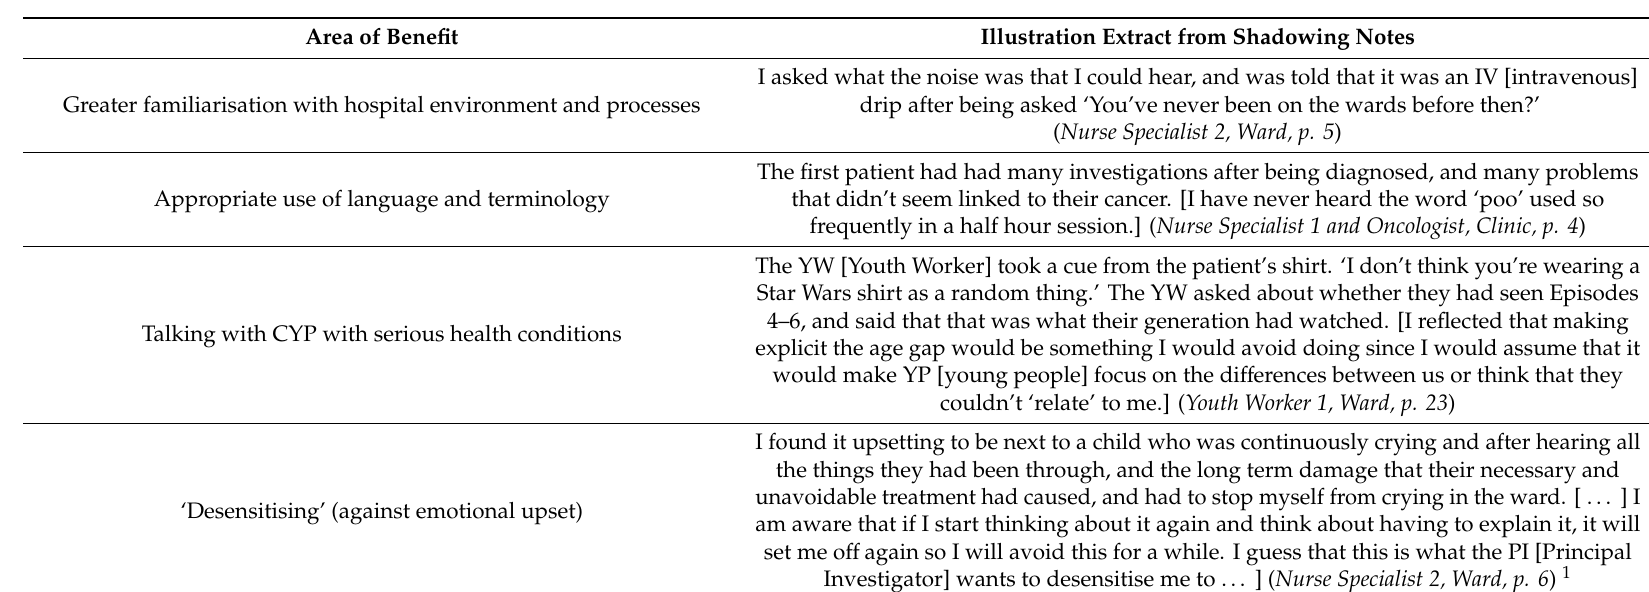
Table 2. Illustrative examples from shadowing